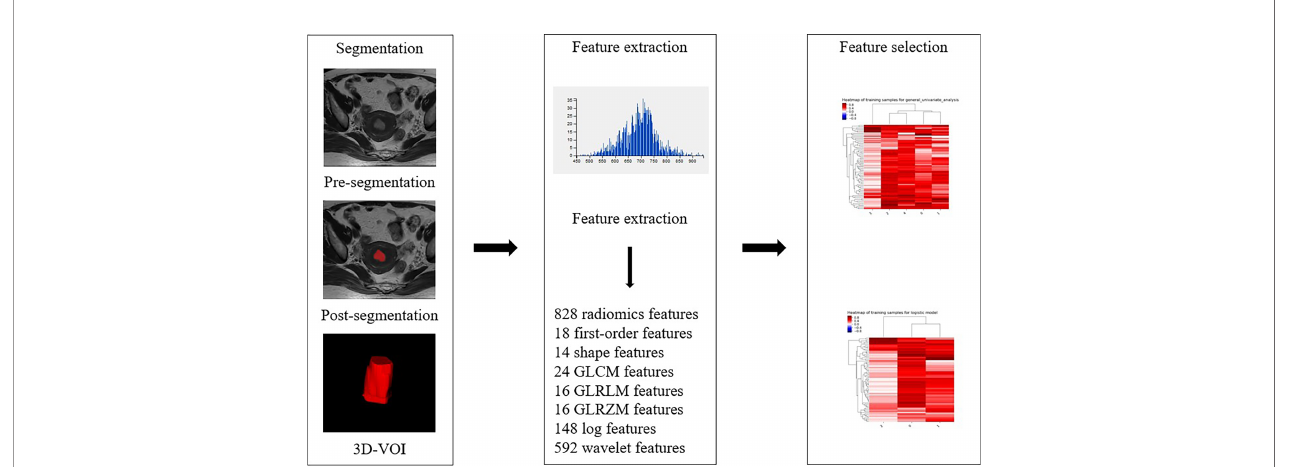
FIGURE 3 | Radiomic work fl